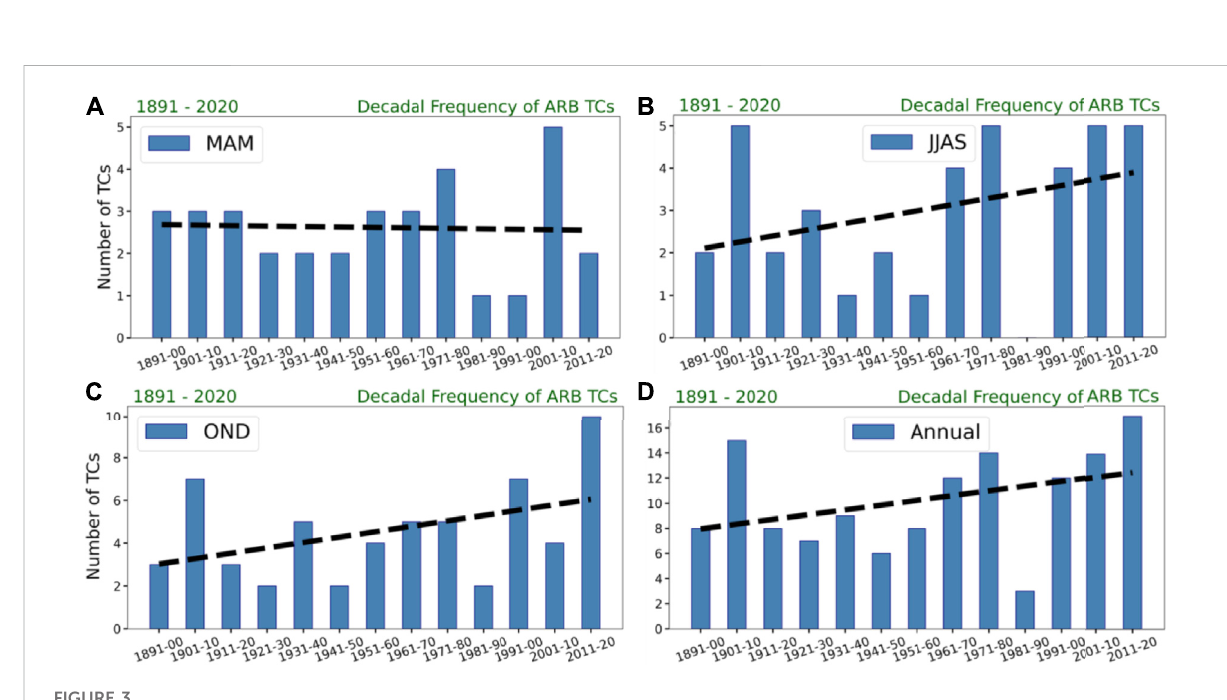
Frontiers in Earth